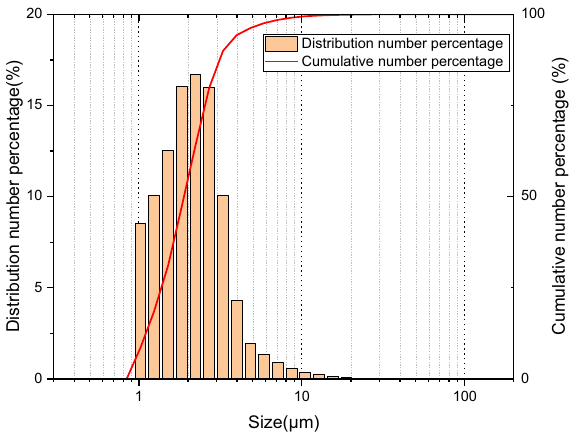
Figure 3. Particle size distribution of dust.